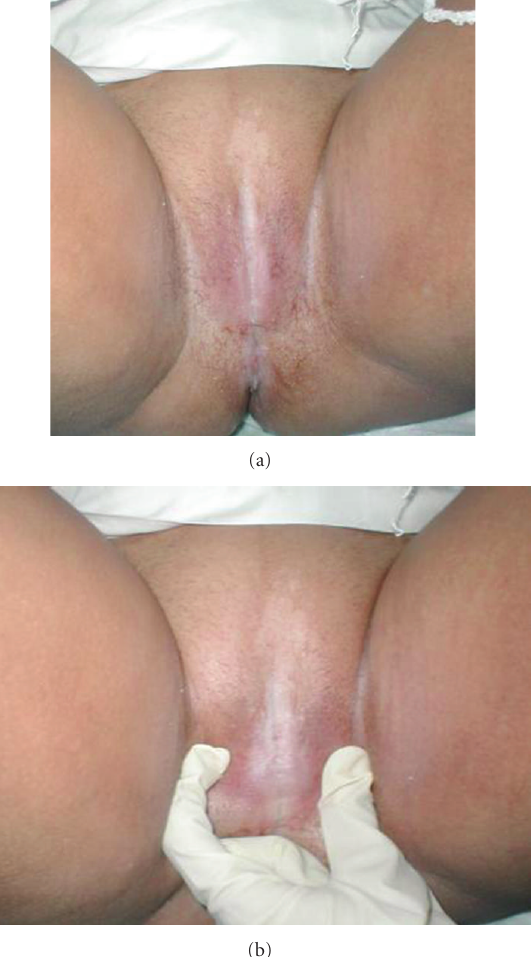
Figure 2: Postoperative photos showing separation of the of vulva using mucocutaneous